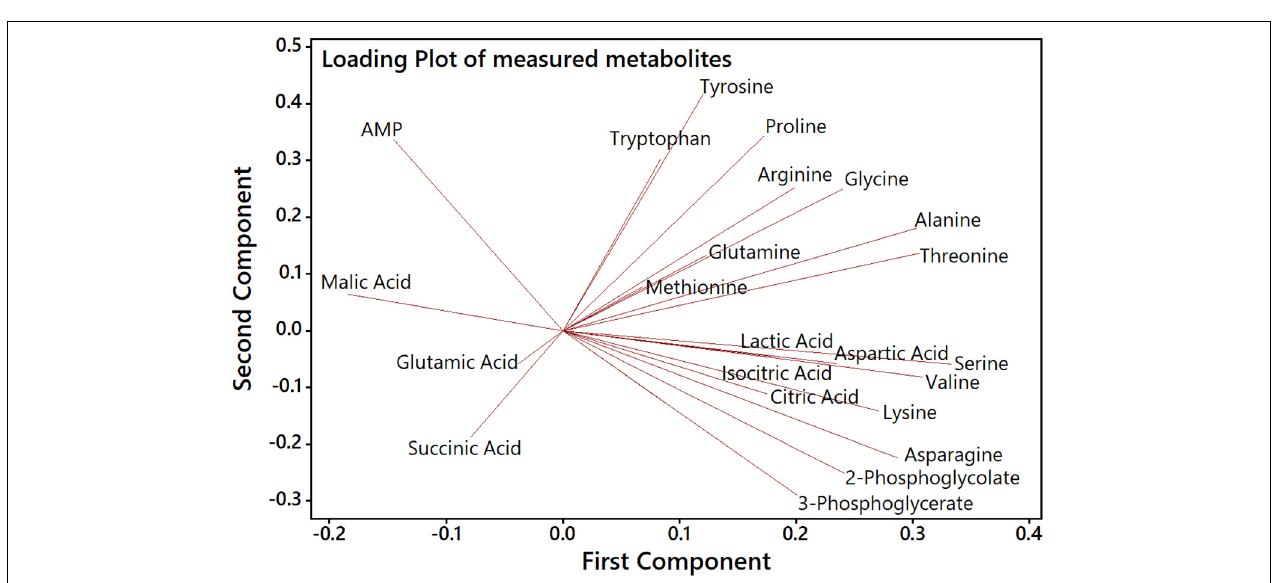
FIGURE 4 | Principal component analysis (PCA) score plot to analyze patterns in samples by genotype and CO 2 treatment during HC-LC-HC shifts. Every data point represents one sample as a combination of genotype and one of the nine sampling time points during the HC-LC-HC shift experiment. HC and LC samples, regardless of sampling time, are represented only by the same respective genotype symbol for clarity reasons. Inserted black lines mark the separation of LC, HC and (cid:49) eda samples, respectively.